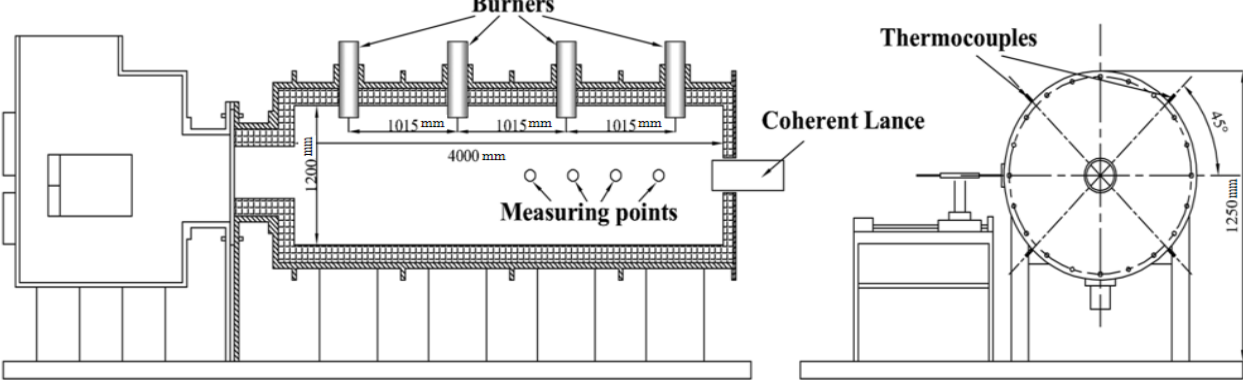
Figure 2. Schematic diagram of the combustion furnace.